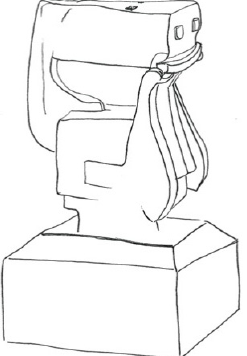
Figure 14. Line drawing of lacquered wood, single-headed Changsha style antlered tomb sculpture from Tomb 109 at Changsha, Hunan. Note, the antlers are not pictured. Adapted from Hunan sheng bowuguan et al. (2000b, 2: pl.121.2-3) courtesy of Zay Olsen.